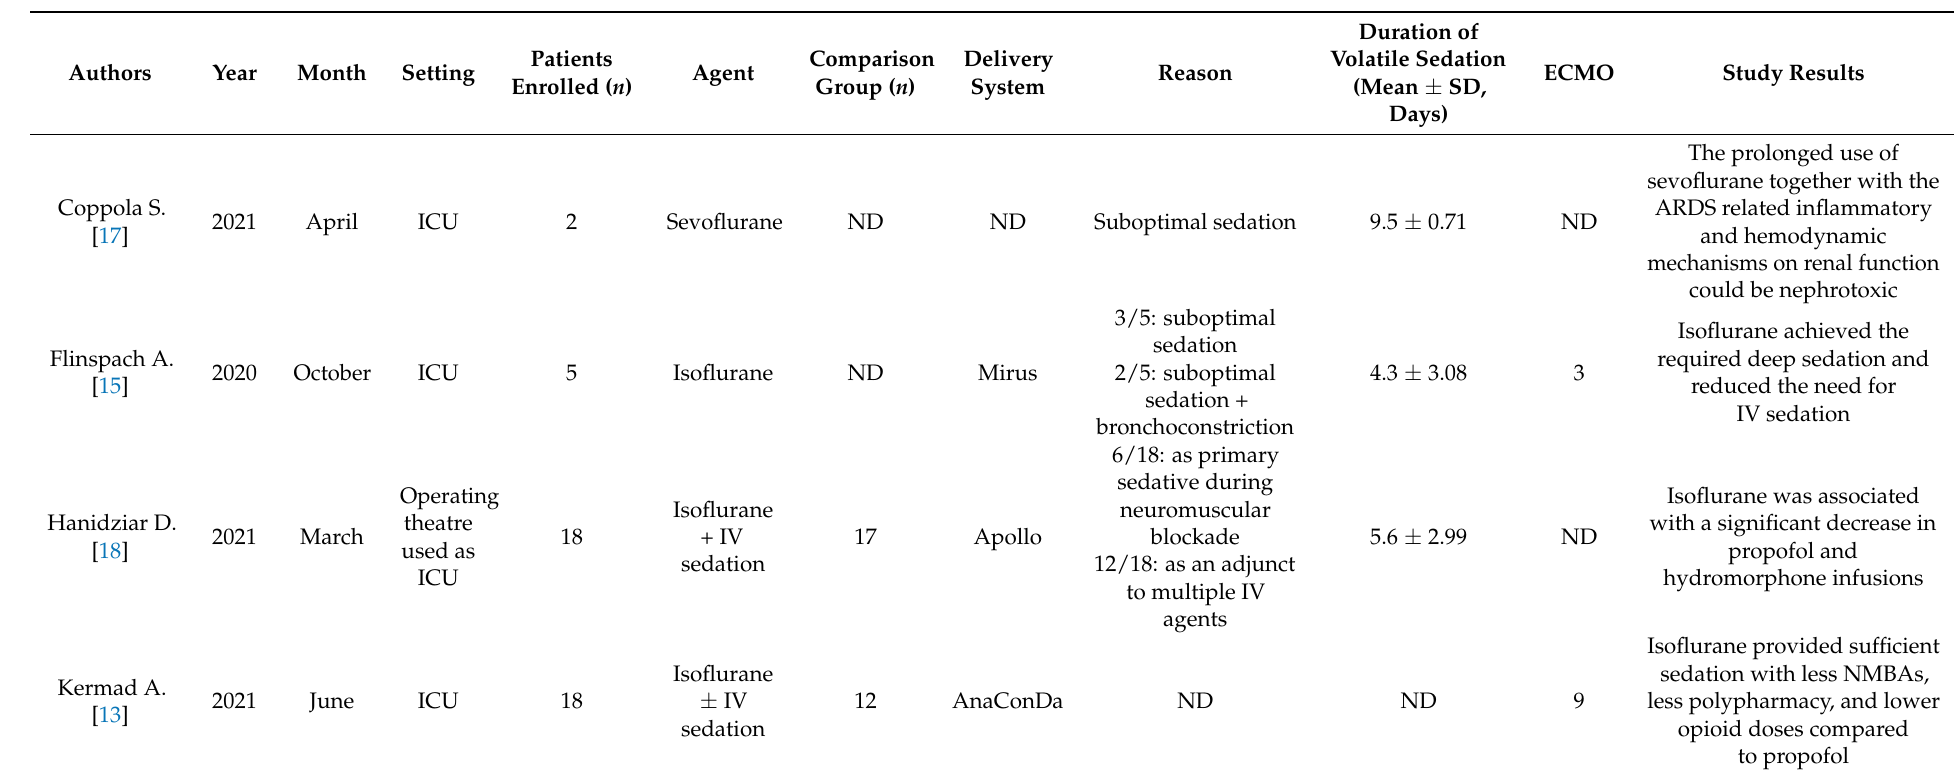
Table 1. Manuscripts with